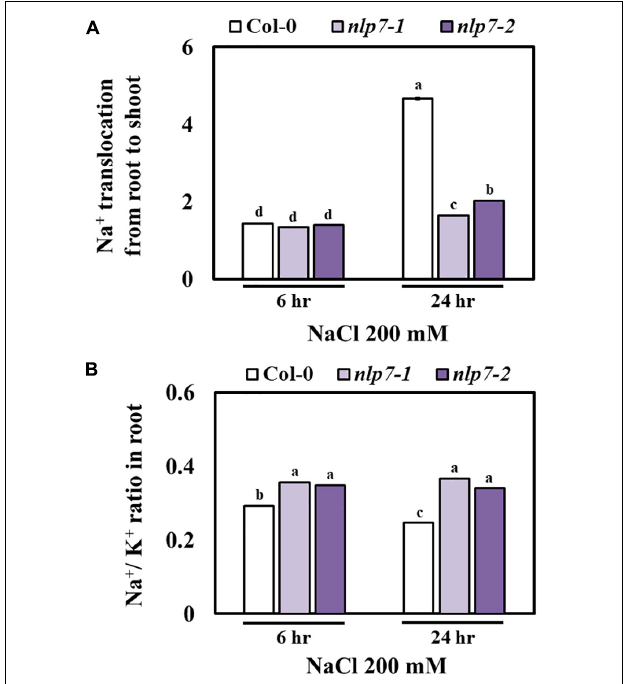
FIGURE 7 | Na + translocation to the shoots of nlp7 mutants was decreased under salt stress. (A) The Na + translocation from the roots to the shoots in Col-0, nlp7-1 , and nlp7-2 seedlings in response to salt stress. The seeds were germinated and grown on a nitrogen-free half-strength MS medium containing 5 mM KNO 3 and then treated with 200 mM NaCl for 6–24 h. Na + translocation from the roots to the shoots was estimated based on the Na + and K + content of the roots and the shoots using ICP-OES (Agilent) calculated from a standard curve obtained with Na + and K + standard solutions. (B) The Na + -to-K + ratio was calculated based on the Na + and K + content of the roots and the shoots of salt-treated Col-0 and nlp7 seedlings. Error bars represent the standard deviation of three independent replicates. Different letters (a, b, or c) within a treatment group indicate significant differences in the two-way ANOVA ( P ≤ 0.05, Tukey’s test).